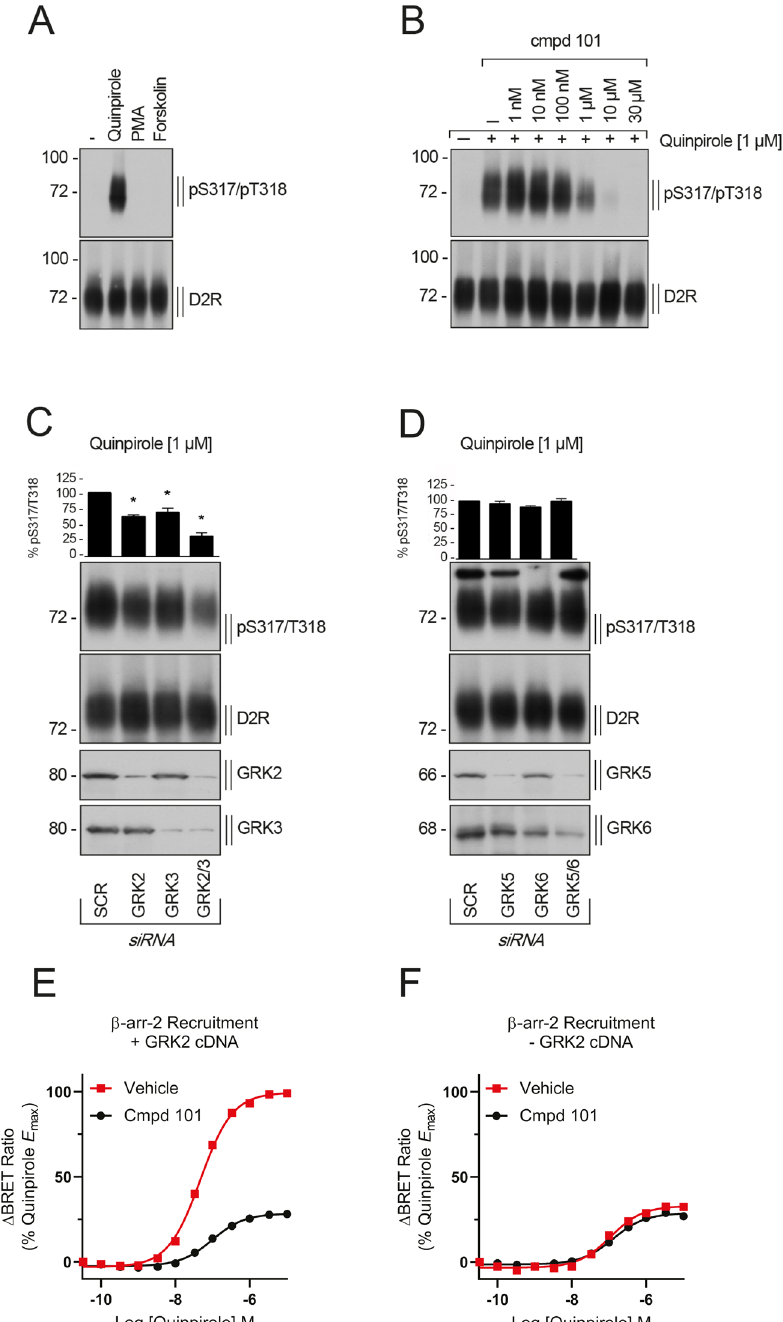
Figure 2. GRK2 and GRK3 mediate phosphorylation at Ser 317 /Thr 318 and enhance β-arrestin-2 recruitment. ( A ) HEK293 cells stably expressing